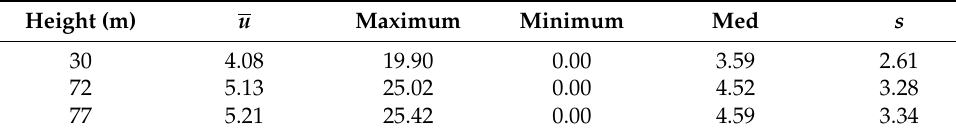
Table 1. Statistical measures of wind speed at different heights.